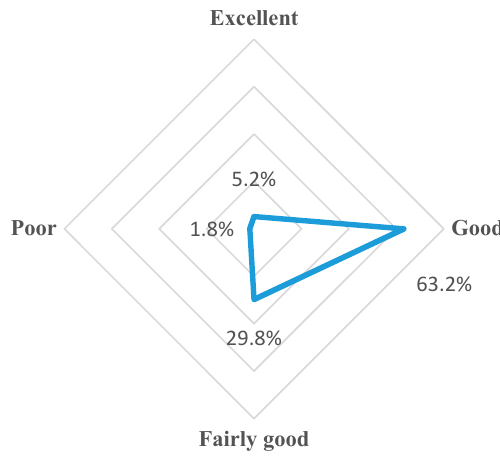
Figure 2. Awareness of Cloud BI applications.